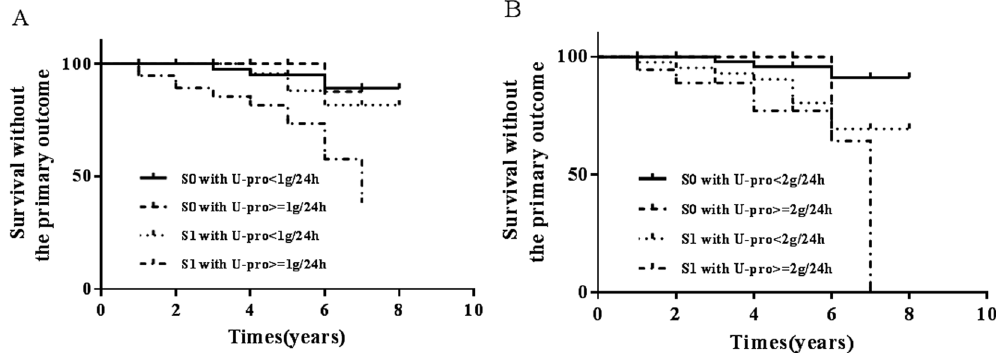
Figure 2. Kaplan–Meier survival curves according to segmental glomerulosclerosis. Kaplan–Meier survival curves stratified according to the scores for segmental glomerulosclerosis combinded with proteinuria levels ≥ or < 1.0 g/24 h at biopsy ( A ), and different T scores combinded with proteinuria levels ≥ or < 2.0 g/24 h at biopsy ( B